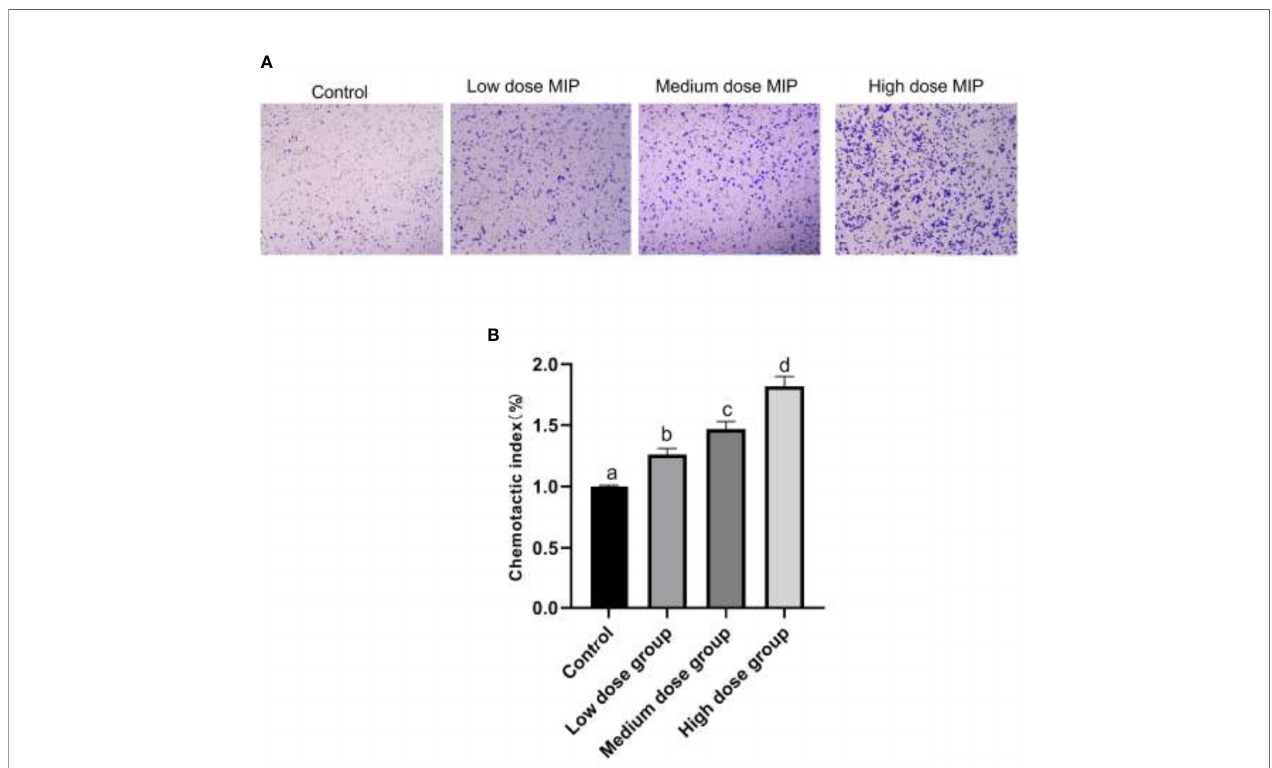
FIGURE 2 | MIP enhances the chemotaxis of RAW264.7. (A) The cytological morphology of RAW264.7 cells that migrated across the membrane in the MIP-free medium, low-dose MIP, medium-dose MIP, and high-dose MIP. (B) Chemotactic index of RAW264.7. The signi fi cant differences were marked by the alphabetic notation (a – d) by using ANOVA. In the control and different concentration treatment groups, the control is marked with the letter a; in the low-dose group, an average that is signi fi cantly different from it is marked with the letter b, otherwise, letter a and continuously marked with letters c and